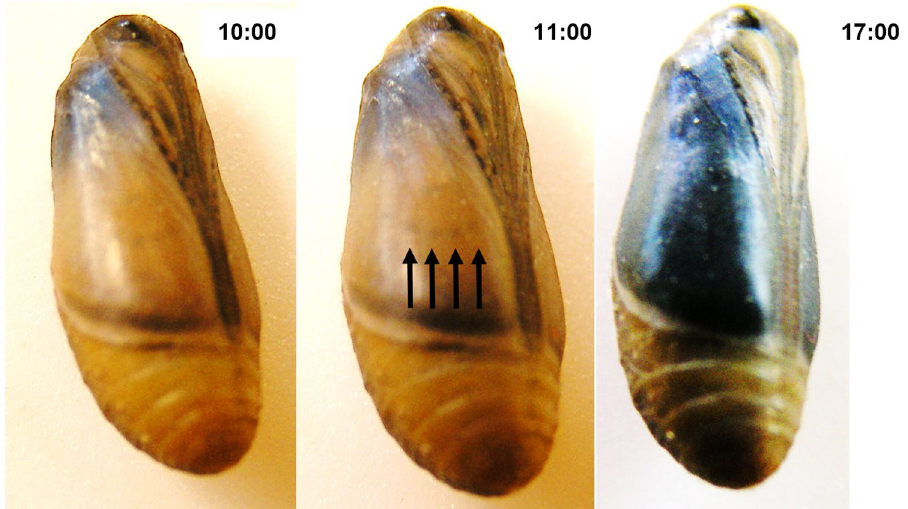
Figure 1. Pupa of a Polyommatus icarus male specimen one day prior to the eclosion of the adult. In the morning hours, the dorsal wing surface visible through the pupal case has a light brown-yellow color, through which the dark spot array from the ventral wing side is visible (arrows in the central image). This indicates that the scales of the dorsal wing surface are still transparent. In the afternoon, the color change is completed, the entire dorsal wing surface appears